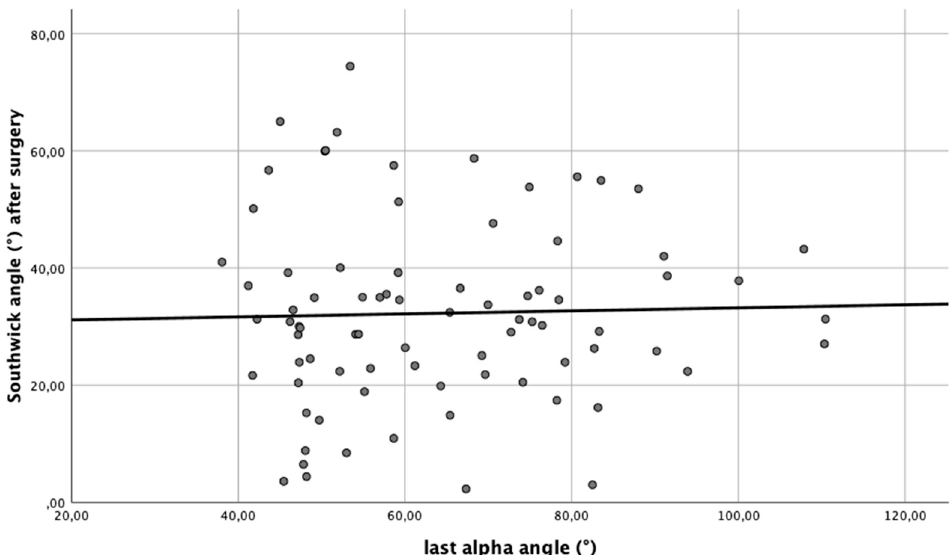
Figure 3. The linear regression between the postoperative absolute Southwick angle and the latest alpha angle showed no significant correlation.